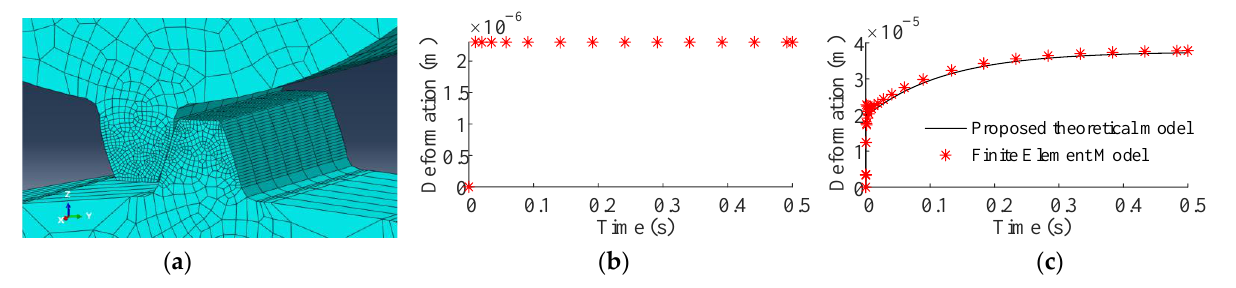
Figure 4. Tooth deformation analysis of steel and epoxy gear: ( a ) finite element model; ( b ) tooth deformation of steel gear pair; ( c ) tooth deformation of epoxy gear pair. Table 3. Basic parameters of mechanical model (Figure 1) for epoxy gear.